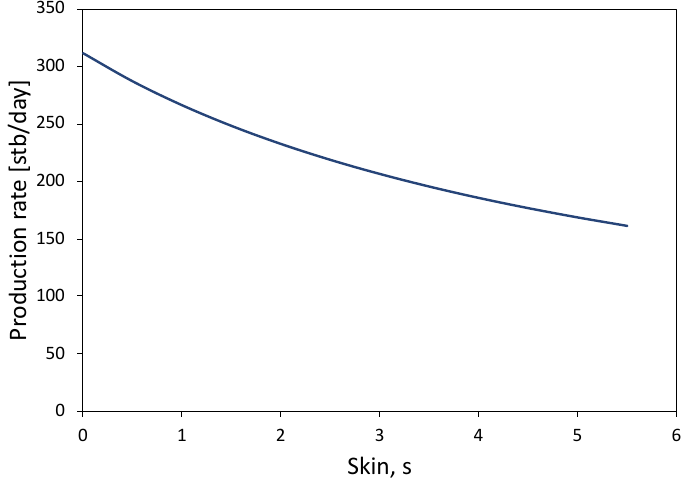
ff ect of skin on well production rate (Well #1). Figure 13. Modeled effect of skin on well production rate (Well #1). Figure 13. Modeled e